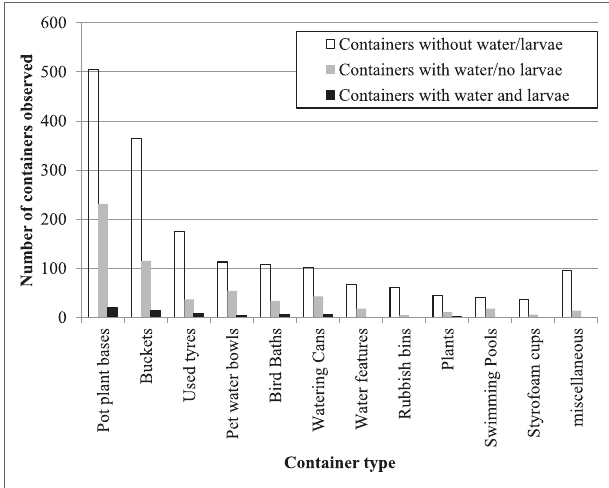
FigUre 2 | Type of containers with the potential to breed mosquitoes identified from backyard inspections within the town of Bassendean, Perth.